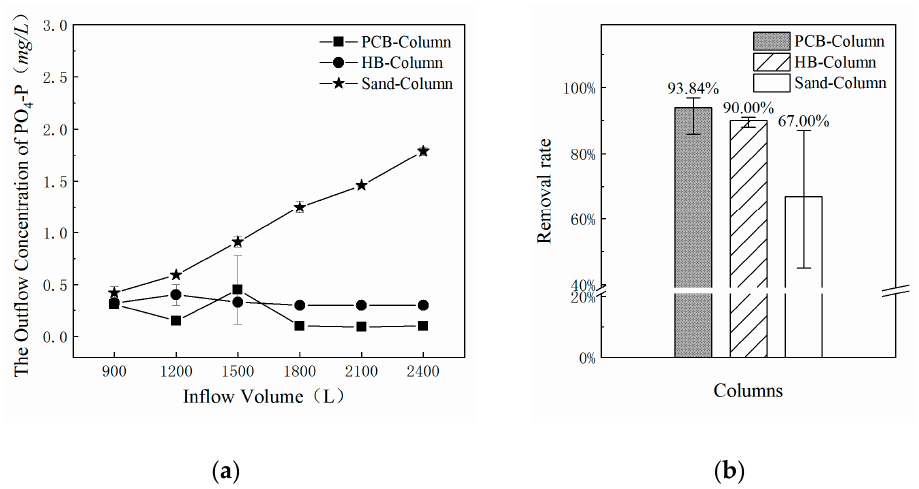
Figure 8. Concentration and mean removal rates of PO 43 − in outflows from the three columns in the second simulated rainfall event. ( a ) The outflow concentrations of PO 43 − from the three columns; ( b ) the mean removal rates of PO 4 -P from the three columns.